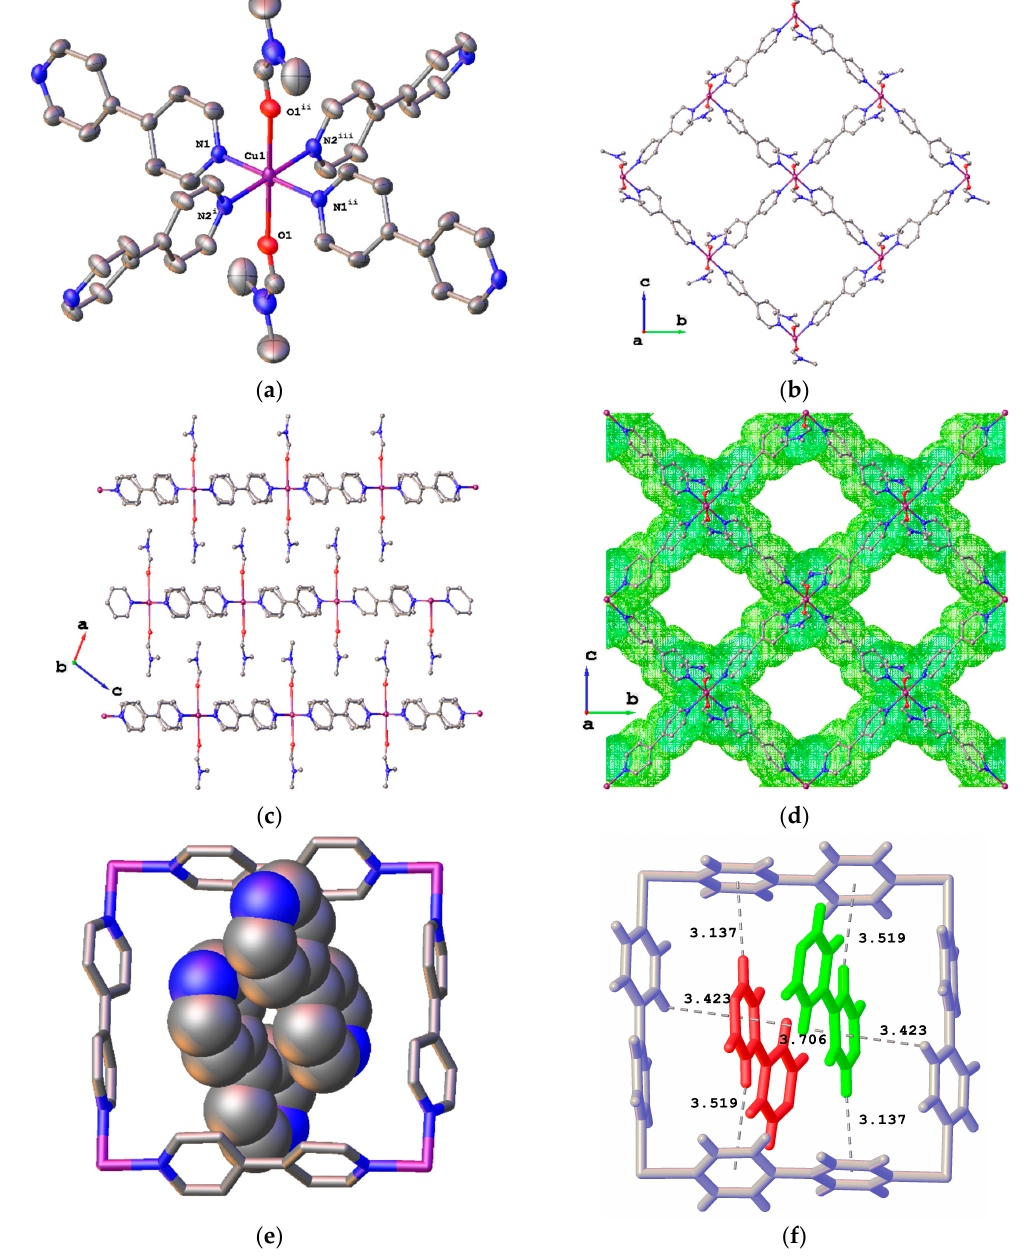
Figure 2. ( a ) Coordination environment of the copper center in compound 4 (thermal ellipsoids drawn at the 50% probability level). ( b ) 2D network (single layer); ( c ) view along the ac plane of alternating and mismatched grids; ( d ) channels formed by the 2D layers (green points). ( e ) Two uncoordinated bpy molecules hosted by a Cu–bpy square. ( f ) CH··· π interactions and π ··· π stacking in the host-guest ensemble. Color code: Cu, purple; O, red; N, blue; C, grey. Anions and H atoms omitted for clarity. Symmetry operations: i = 2 − x , 1 − y , 1 − z ; ii = 1/2 + x , 3/2 − y , 1/2 + z ; iii = 3/2 − x , 1/2 + y , 1/2 − z .